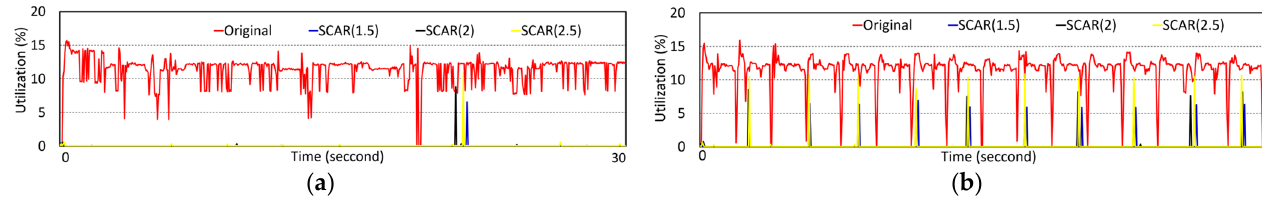
Figure 10. Variation in GPU utilization on Hotels.com: ( a ) scrolling speed of 100 pixels/s; ( b ) scrolling speed of 1000 pixels.